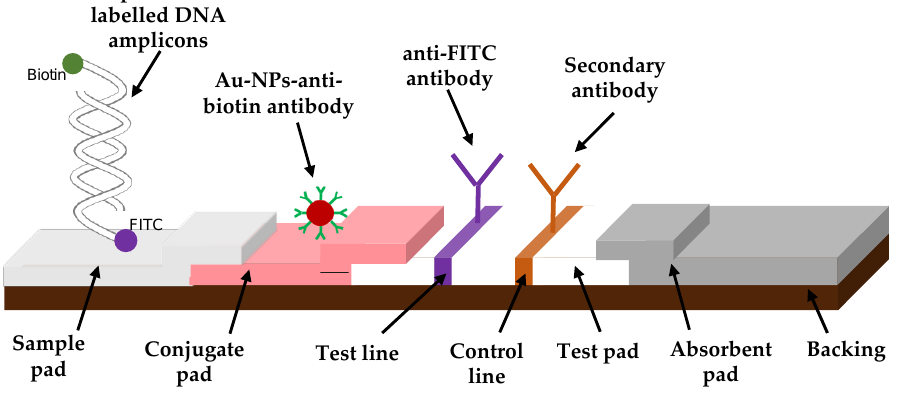
Figure 1. Schematic diagram of the fabricated immuno-dipstick.